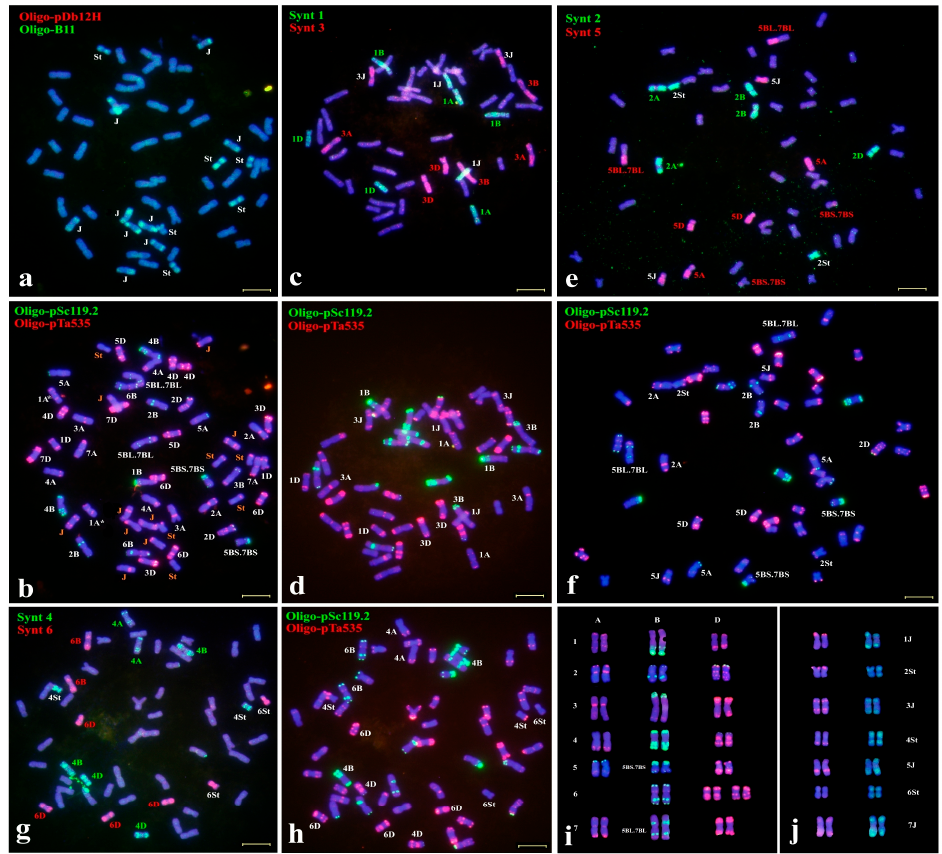
Figure 2. Sequential FISH probes Oligo-B11 + Oligo-pDb12H ( a ), Oligo-pSc119.2 +Oligo-pTa535 ( b , d , f , h ) and Oligo-FISH painting using specific bulked oligo probes Synt1+ Synt3 ( c ), Synt2 + Synt5 ( e ) and Synt4 + Synt6 ( g ) for wheat– Th. intermedium partial amphiploid TAF46, respectively. Karyotype of wheat chromosomes ( i ) and Th. intermedium ( j ) are shown. Chromosomes were counterstained with DAPI (blue). Bars, 10 µ